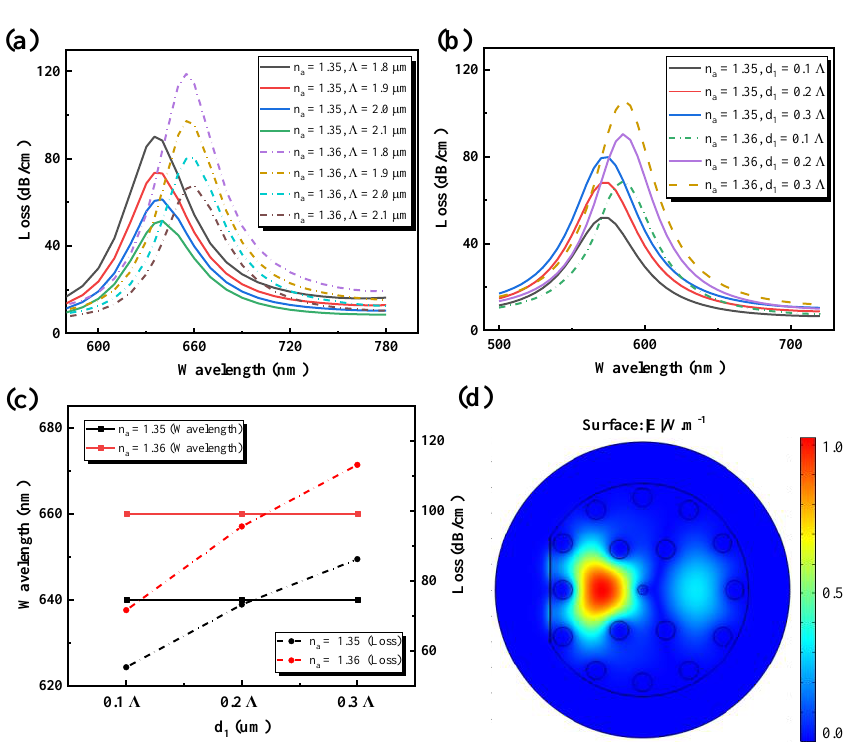
Figure 4. Influence of PCF structure parameters on the loss spectrum curve. ( a ) Air holes pitch, Λ ; ( b ) Air holes diameter, d 1 ; ( c ) Resonance wavelength varies with the diameter, d 1 ; ( d ) d 1 = 0.2 Λ optical field distribution.